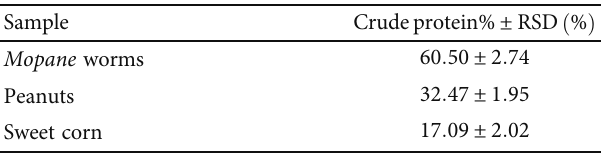
Table 1: Percentage mean crude protein ( n = 3 ) of mopane worms, sweet corn, and